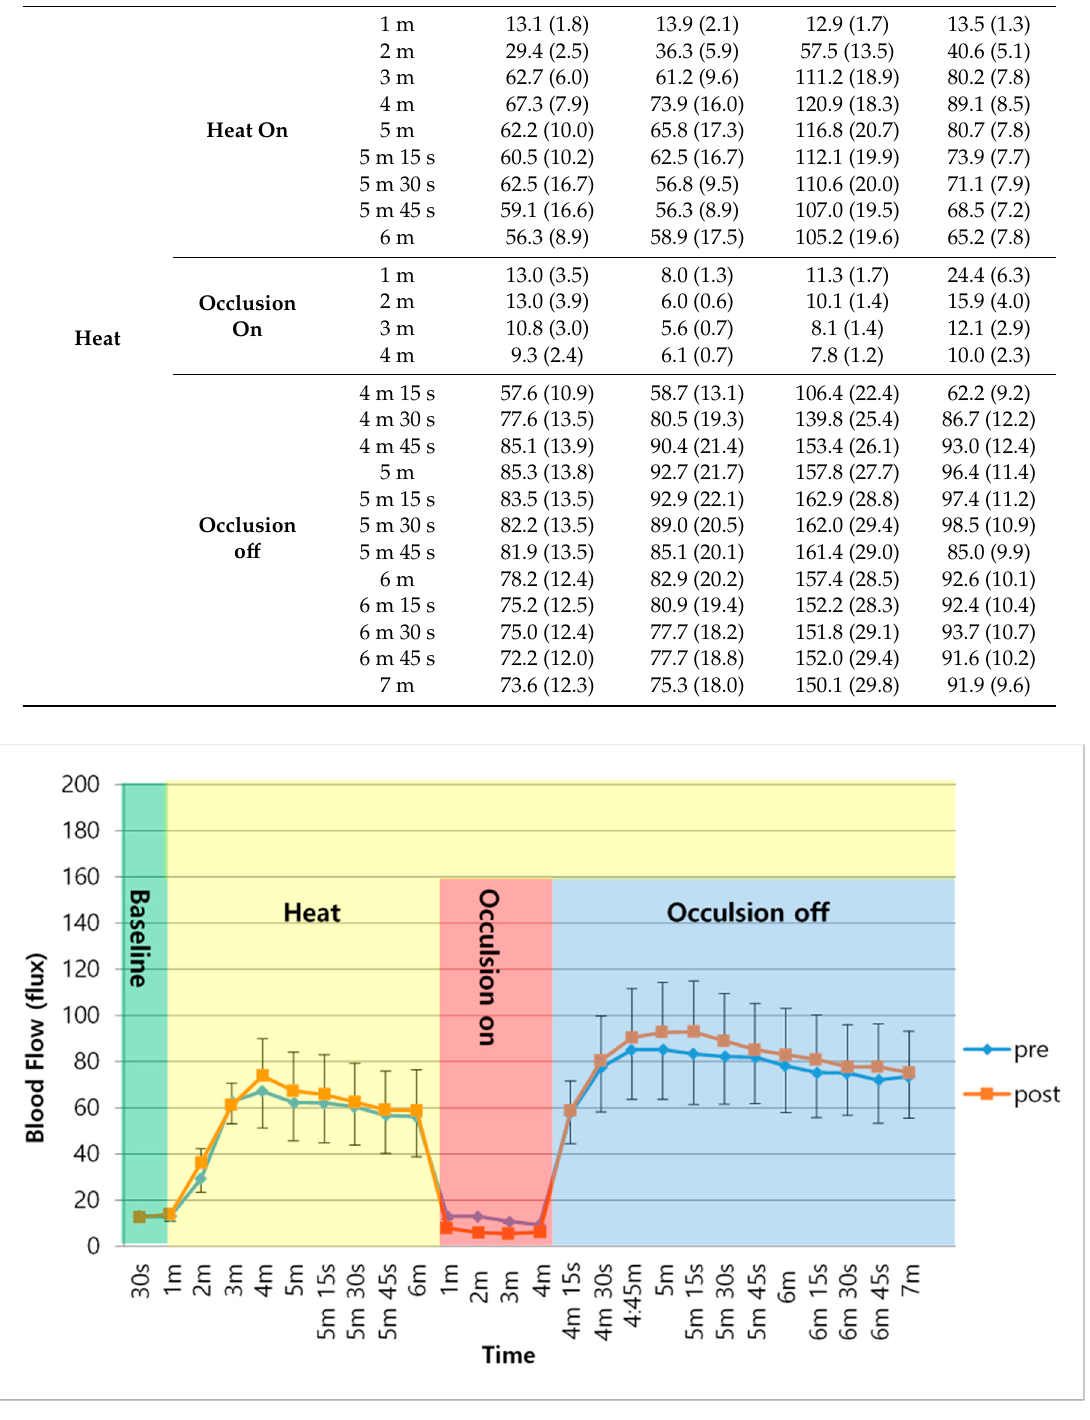
Figure 2. Mean and SD of Skin blood flow over time between pre- and post-intervention in diabetic group.